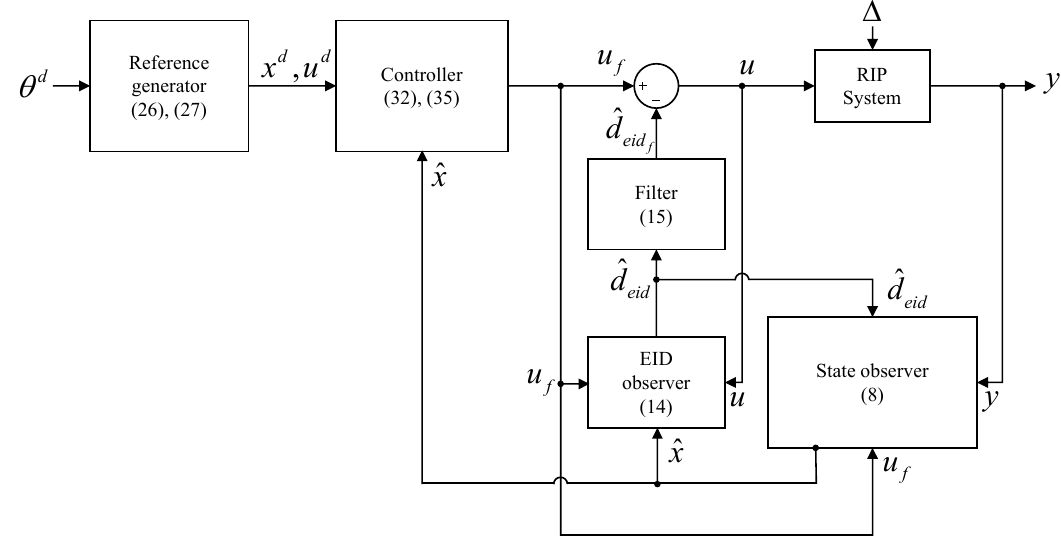
Figure 2. Block diagram of the proposed